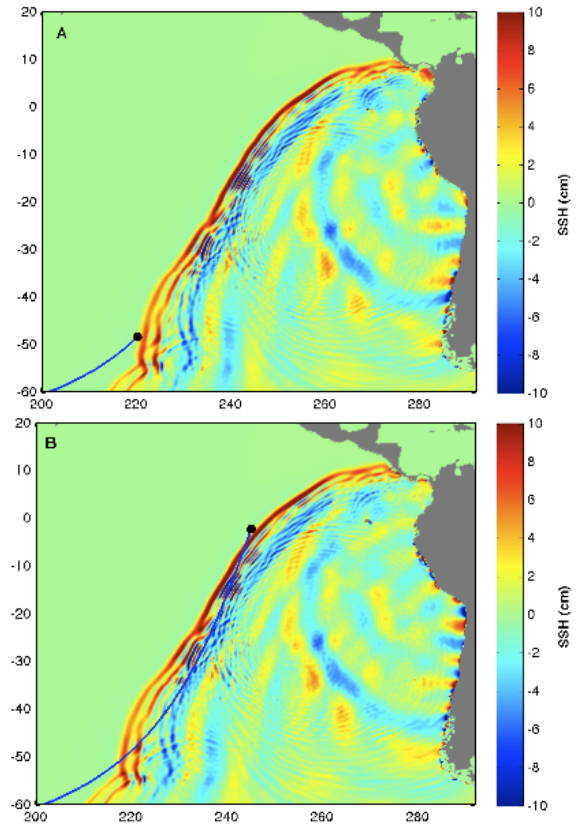
Fig. 14. MOST model results at the time Jason-1 entered the tsunami wave field on pass 143 (according to the model) (A) and at the time Jason-1 departed the tsunami wave field (B) . The time between the two images is ∼ 15min. The oblique sampling of the leading front of the tsunami by Jason-1 provides a possible expla- nation for the discrepancy between model results and Jason-1 data as seen in Fig.